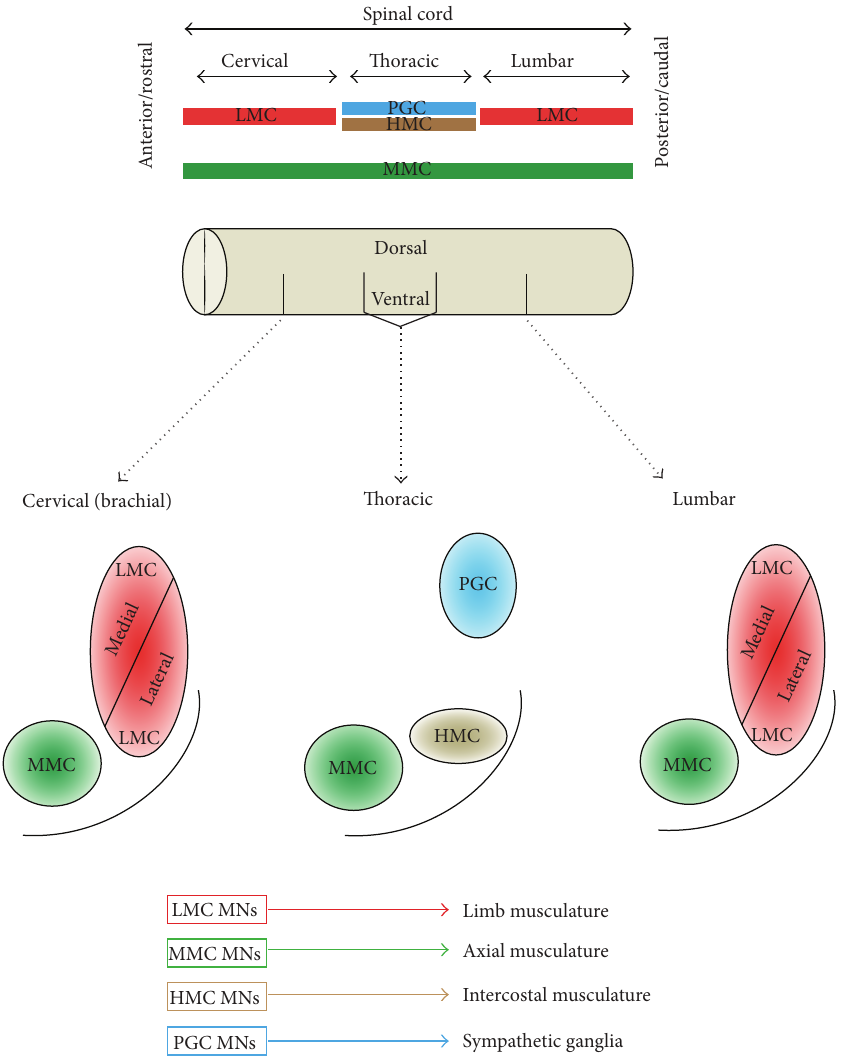
Figure 4: A schematic depicting columnar arrangement of motor neuron subtypes in relation to different rostrocaudal portions of the neuraxis. The LMCs exist only at cervical (brachial) and lumbar foci and are responsible for innervating the muscles of the upper and lower limbs, respectively. The MMC exists throughout the rostrocaudal extent of the spinal cord and is responsible for innervating axial musculature. The HMC and PGC exist only in thoracic portions of the spinal cord and innervate the intercostal musculature and sympathetic ganglia, respectively. R-C: rostrocaudal; LMC: lateral motor column; MMC: medial motor column; HMC: hypaxial motor column; PGC: preganglionic motor column; MN: motor